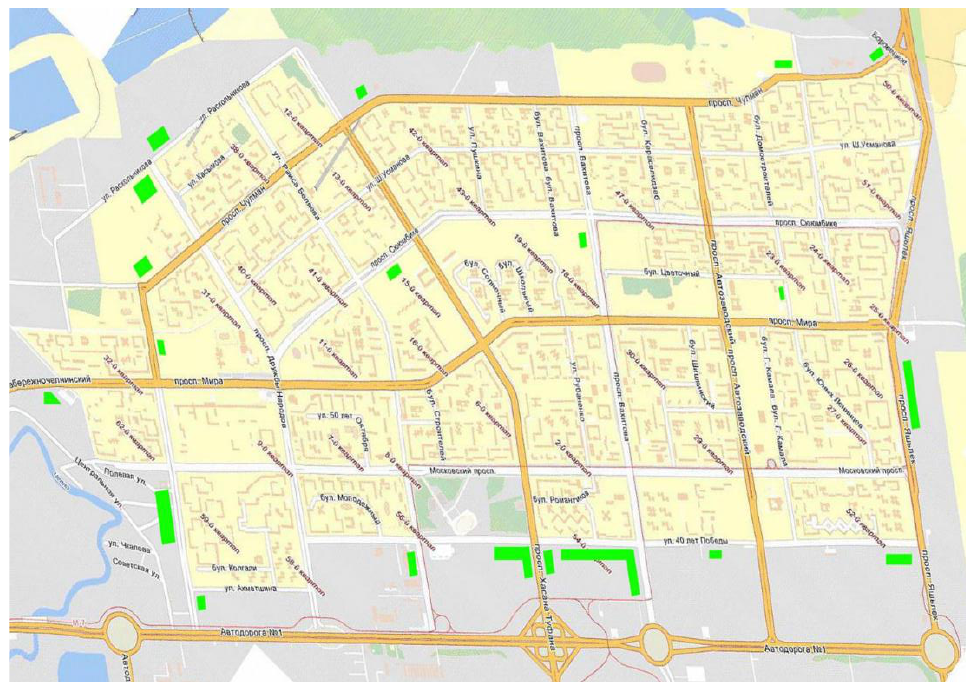
Figure 3. Places of possible construction of parking